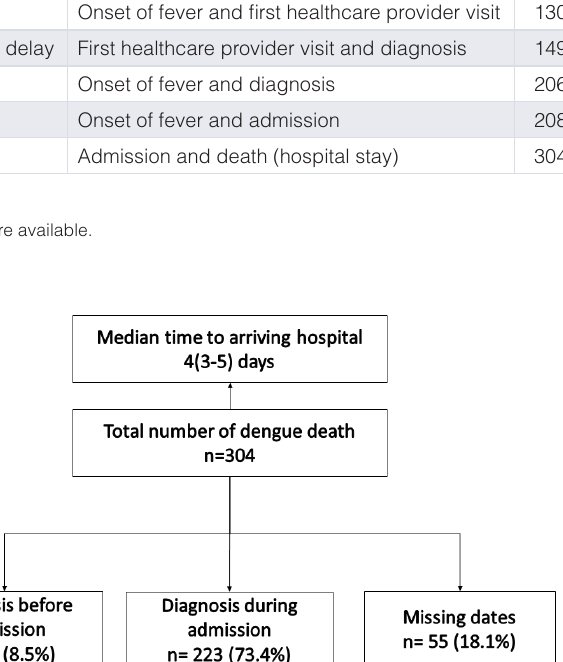
Table 3. Diagnosis delays and admission time among dengue deaths reported to the national programme in Myanmar (2017–18). Delay